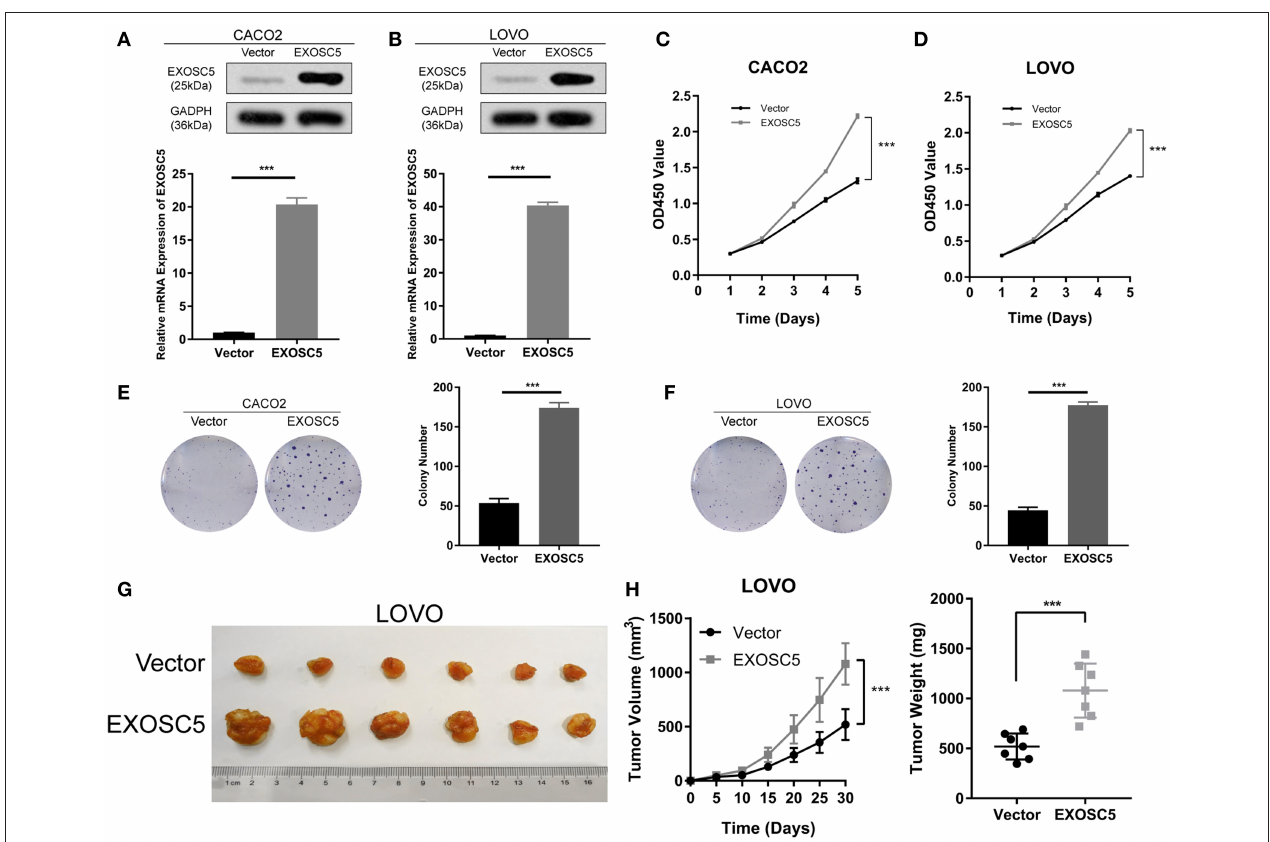
FIGURE 3 | Overexpression of EXOSC5 promoted the proliferation and tumorigenesis of human CRC cells in vivo and in vitro . (A,B) The efficiency of EXOSC5 overexpression in CACO2 and LOVO cells were determined by Western blot, GAPDH was used as a loading control. (C–F) Overexpression of EXOSC5 promoted cell proliferation by CCK-8 assays and colony formation assays. (G) Tumorigenesis assay by subcutaneous injection of LOVO/Vector and LOVO/EXOSC5 cells in nude mice ( n = 6/group). (H) Tumor volumes were measured by growth curve every 5 days, and weights were measured on the terminal days. The results are presented as the mean ± SD. (*** P <